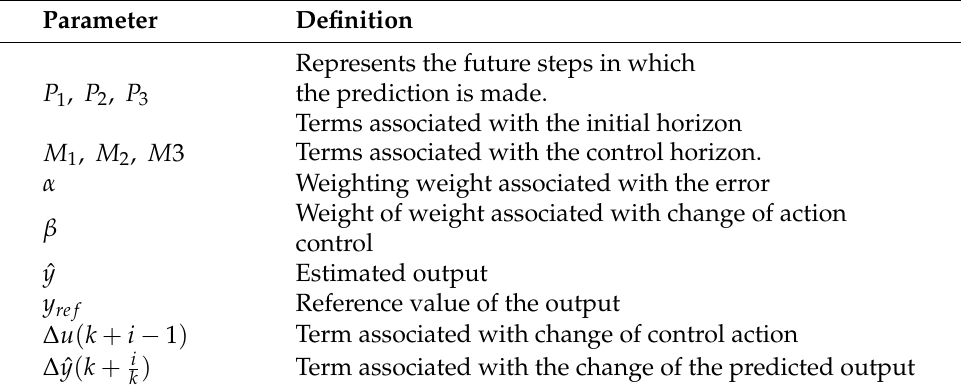
Table 3. Identification of values to tune in the